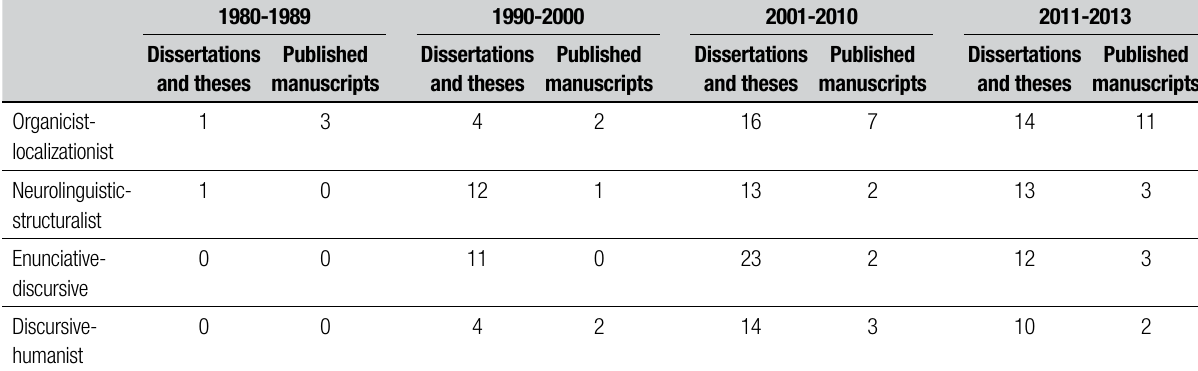
Table 1. Academic output in Brazil in the field of Linguistics on Neurological Disorders